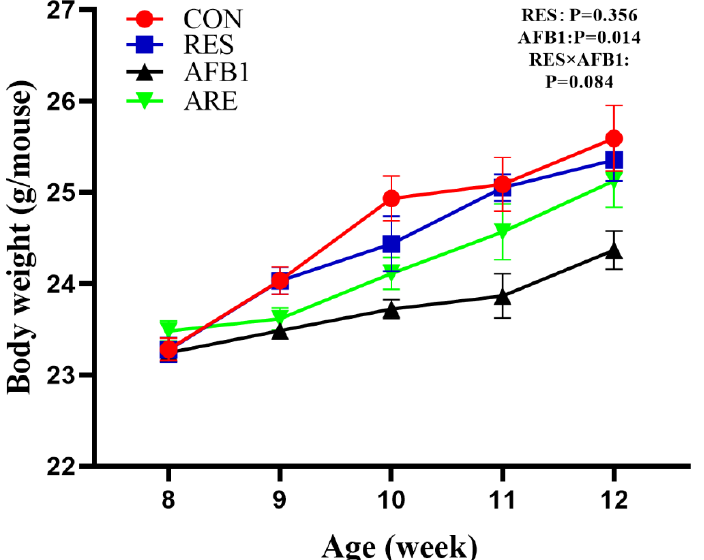
Figure 2. The effect of resveratrol on AFB 1 -induced body weight gain in mice. The body weights were recorded every week. CON, basal diet; RES, basal diet + 500 mg/kg resveratrol. AFB 1 , basal diet + 600 μg/kg aflatoxin B 1 ; ARE, basal diet + resveratrol (500 mg/kg) and aflatoxin B1 (600 μg/kg). All data were analyzed using two-way ANOVA. Data are represented as mean ± SEM, n = 8.